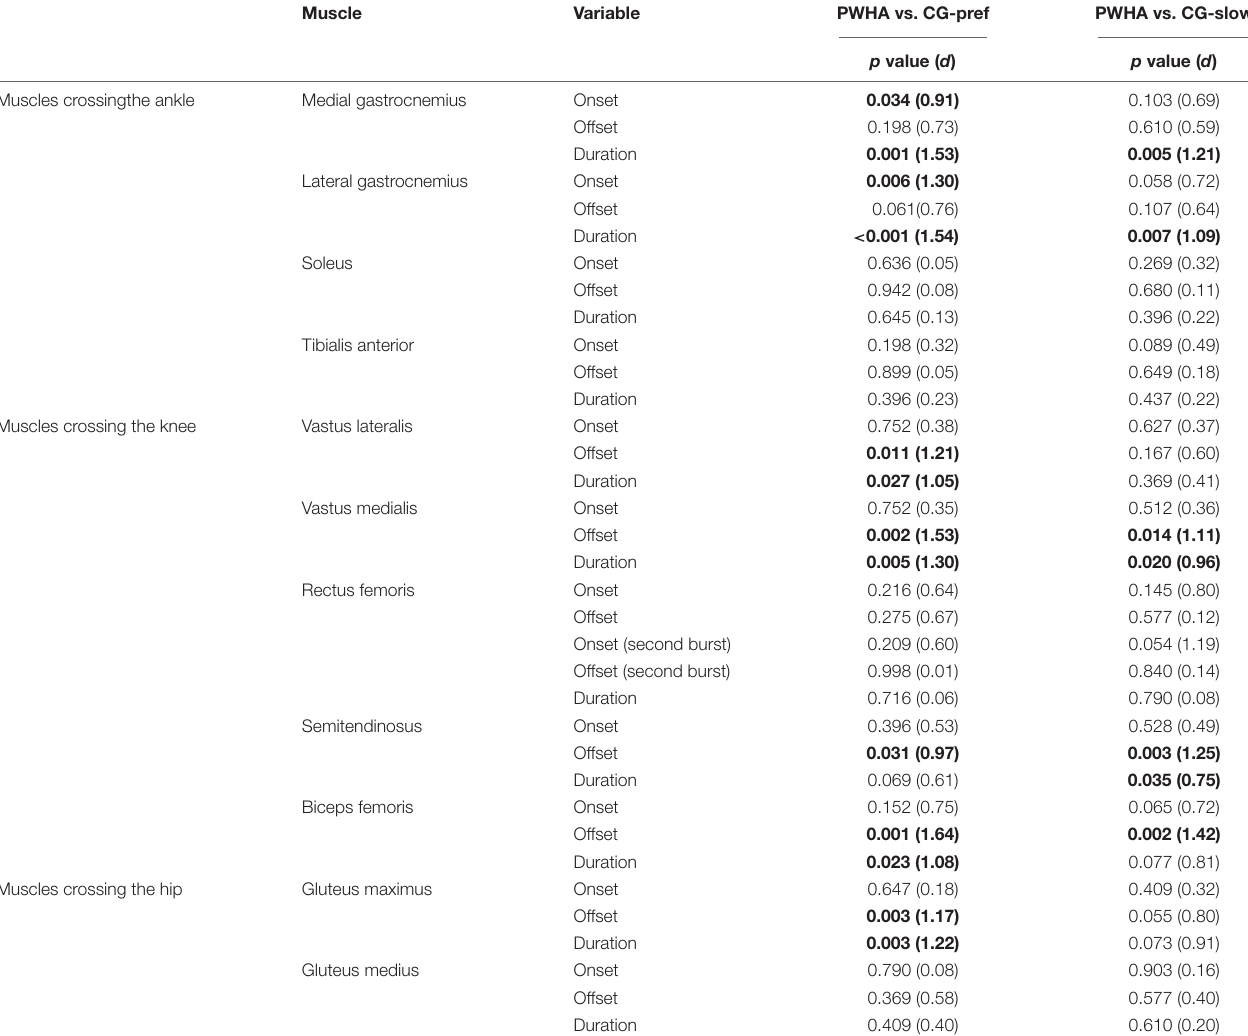
TABLE 3 | Statistical results ( p values) and effect size (ES) for EMG burst onset–offset and burst duration.